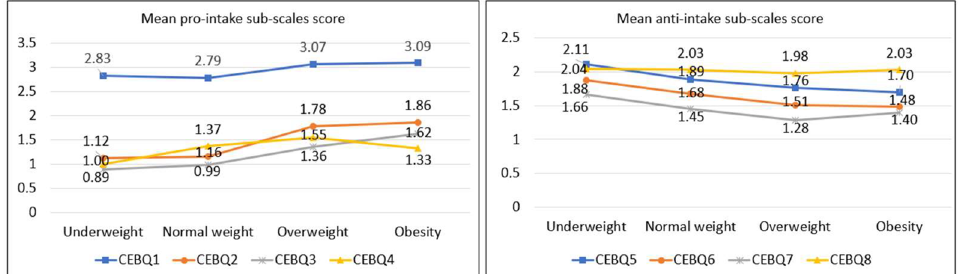
Figure 1. Mean scores of the pro-intake and anti-intake dimensions according to body mass index (BMI) categories [30,31]. Contrast of means using the H-Kruskal Wallis test; p -value CEBQ1 = 0.010; p -value CBQ2 < 0.001; p -value CBQ3 = 0.003; p -value CBQ4 = 0.172; p -value CEBQ5 = 0.011; p -value CEBQ6 = 0.004; p -value CEBQ7 = 0.211; p -value CEBQ8 = 0.582.